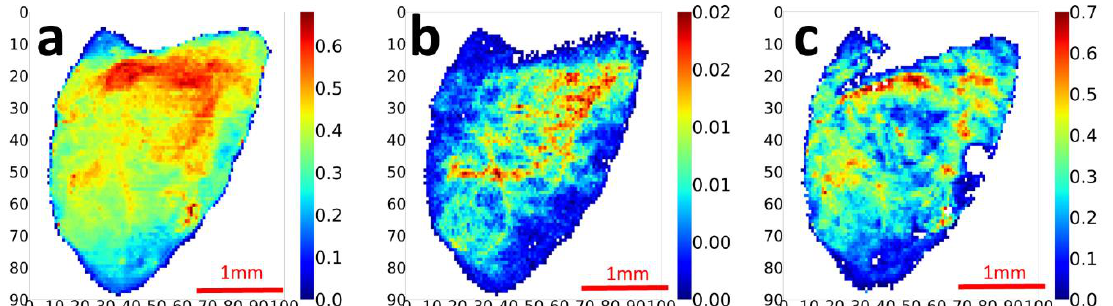
Figure 2. Contrast 2D mapping images with SAXS show complementary collagenous and interfibrillar peak concentrations: Color maps with each SAXS pattern are obtained by calculating different peaks in the radial intensity profile plot for ( a ) whole intensity mapping image, ( b ) Collagen I[c] background-corrected intensity and ( c ) IFC I[ifc] background-corrected intensity. Here and in following figures, the x- and y-axes are in scan number indices.